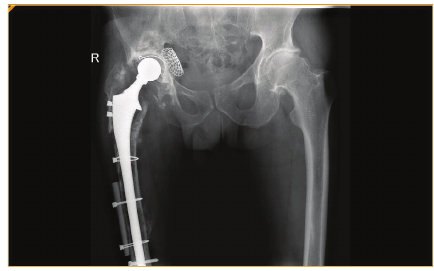
Figure 4: Postoperative fixation of periprosthetic